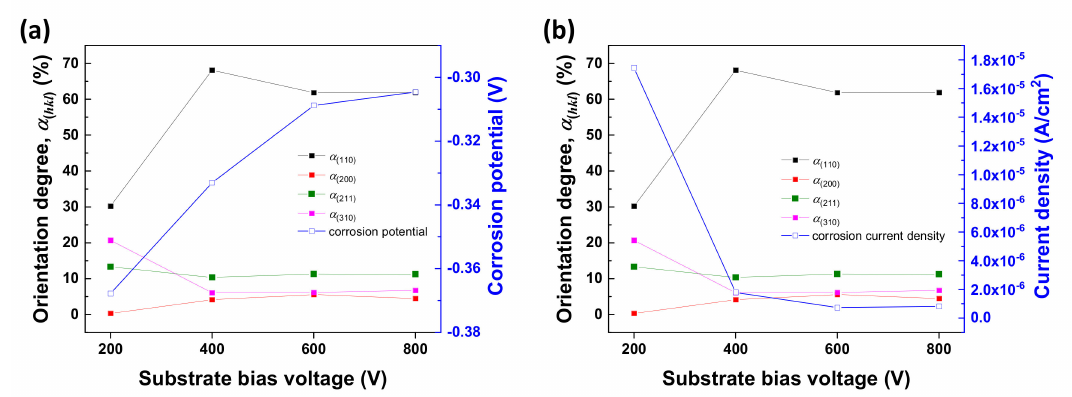
Figure 8. The texture variation due to bias voltage, and its effect on the corrosion ( a ) potential and ( b ) current